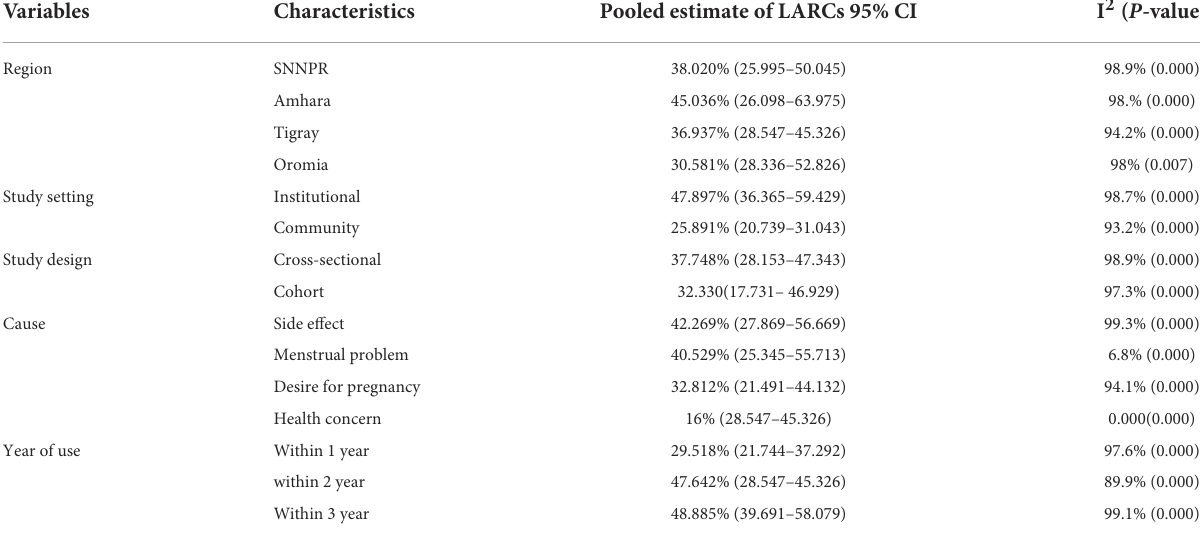
TABLE 2 The overall estimated of discontinuation of long acting reversible contraceptive in Ethiopia, 95% CI, and heterogeneity estimate with a p -value for sub-group analysis.